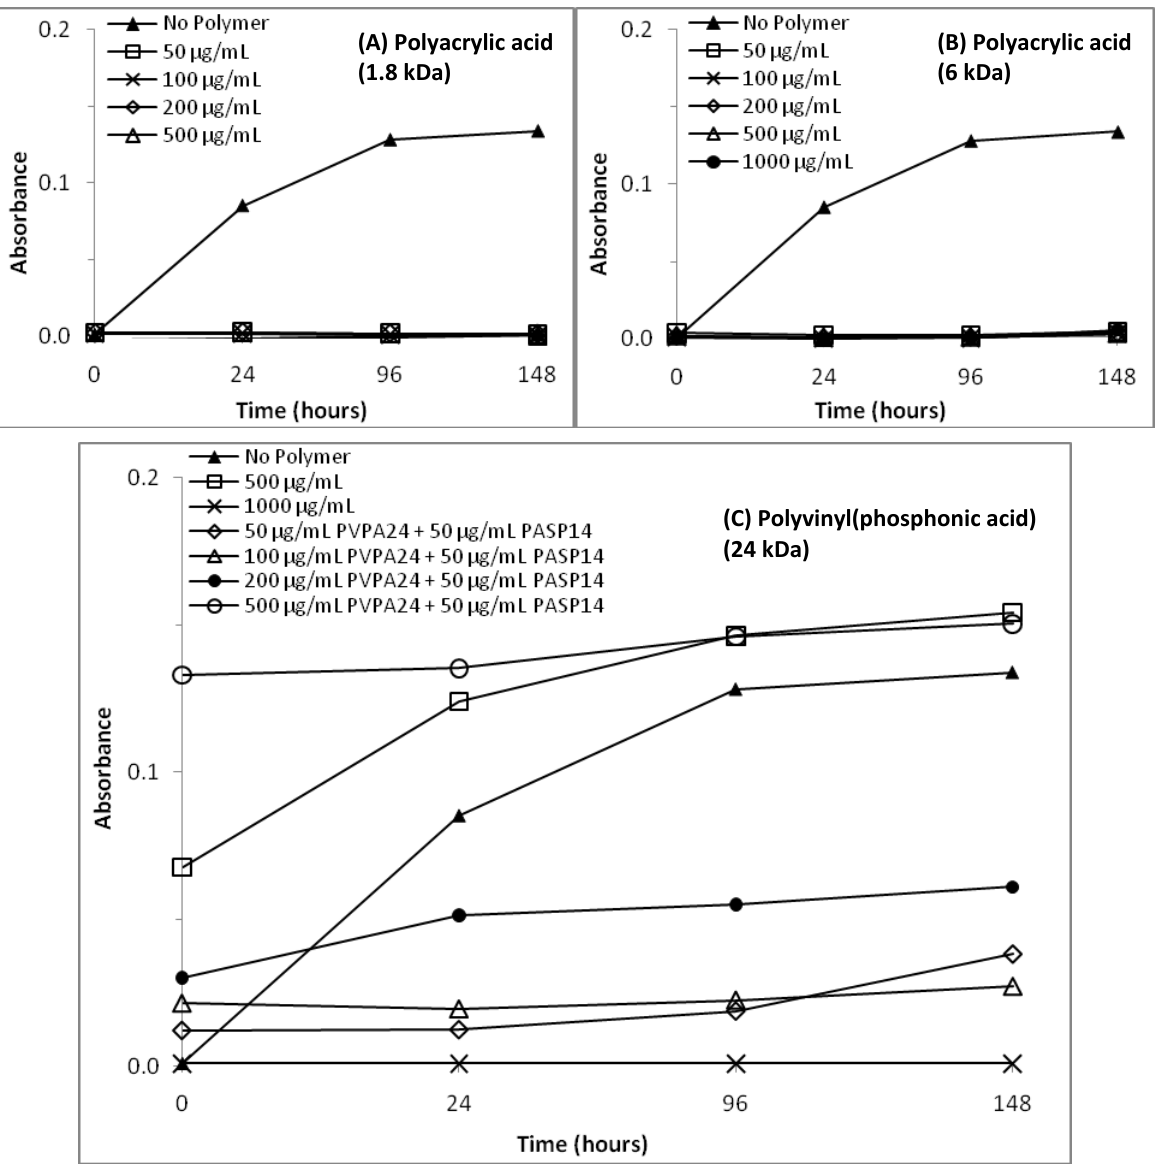
Figure 2. Effects of polyacrylic and polyvinyl(phosphonic acid) concentrations in a supersaturated calcium-phosphate (CaP) solution. ( A ) Optical density profiles of the CaP solutions containing 0–500 µg/mL of 1.8 kDa polyacrylic acid (PAA1.8). The lines for all concentrations are overlapping near zero. ( B ) Optical density profiles of the CaP solutions containing 0–1,000 µg/mL of 6 kDa polyacrylic acid (PAA6). The lines for all concentrations are overlapping near zero. ( C ) Optical density profiles of the CaP solutions containing 0–1,000 µg/mL 24 kDa polyvinyl(phosphonic acid) (PVPA24) and a combination of PVPA24 and